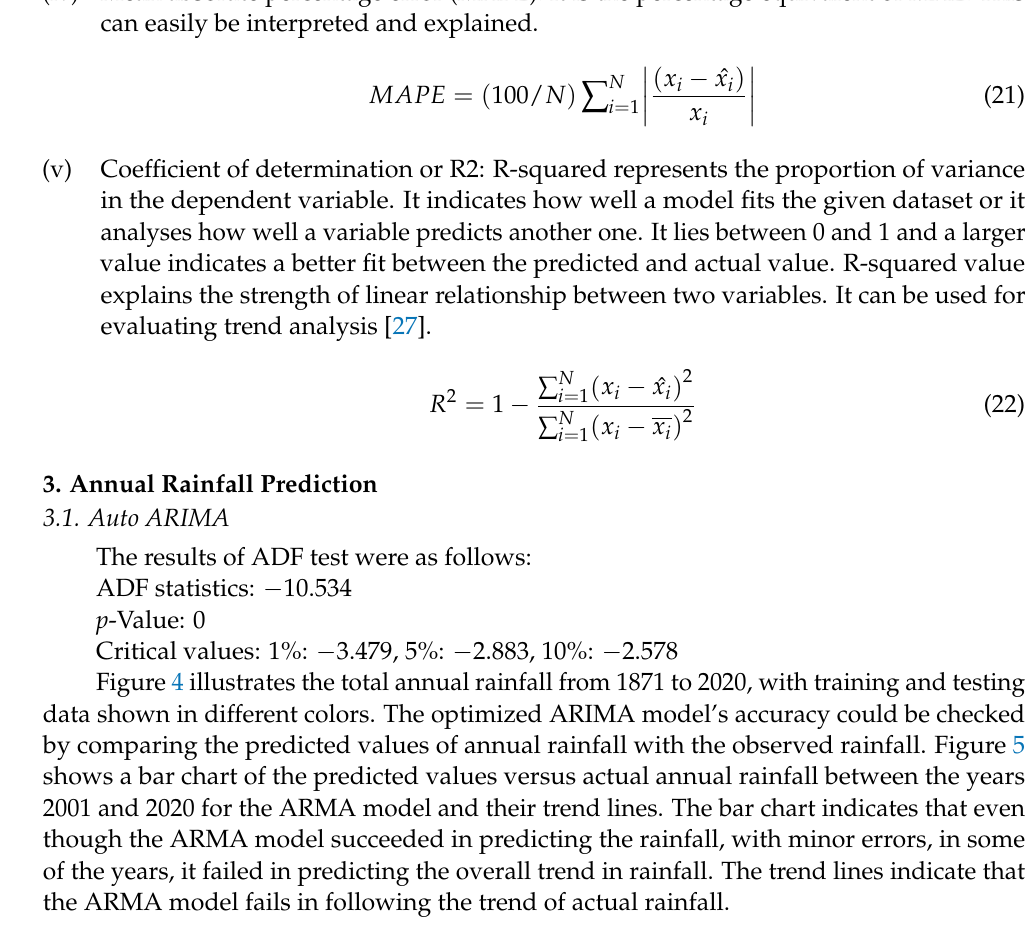
(iv) Mean absolute percentage error (MAPE): It is the percentage equivalent of MAE. This